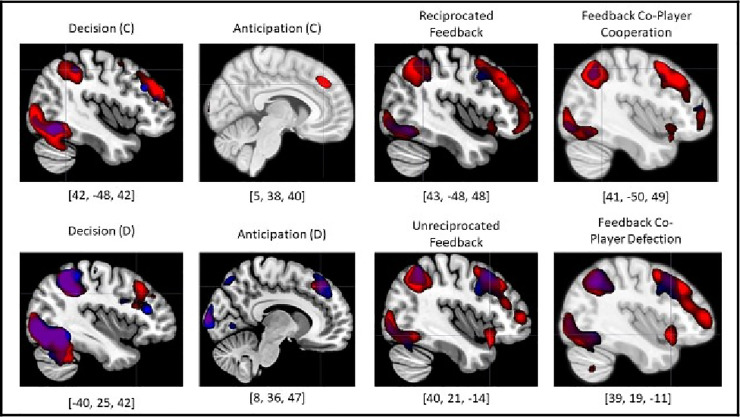
BOLD activity during all phases of the iPD task.In each contrast map the cursor is placed within the peak voxel of activity for each condition. The dmPFC and the bilateral TPJ were the only regions that were recruited across all three phases of the task, suggesting that the PD task serves as a valid and robust model of social reciprocation despite its underlying economic principles. (Decision and feedback phases are thresholded at t(29) = 6.00, p < .05; FWE-corrected voxel-wise threshold while the anticipation phase was thresholded at t(29) = 3.40, p < .001 uncorrected voxel-wise threshold; FWE-corrected cluster-wise threshold determined by SPM12). (Red = Human Game, Blue = Computer Game, C = Cooperate, D = Defect). Ex. [42, –48, 42] = peak voxel MNI coordinates.